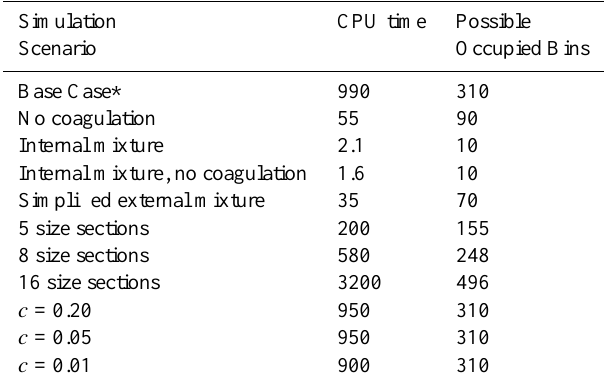
Table 7. Comparison of computational time requirements for dif- ferent model